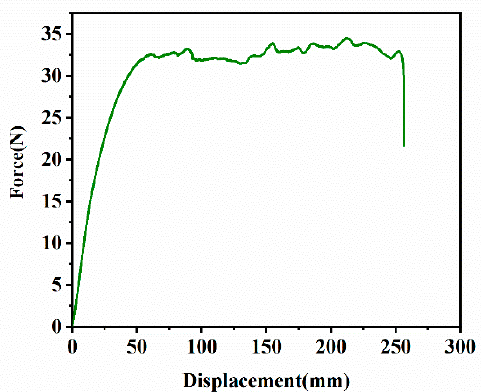
Figure 7. Force-displacement curve of the EPDM rubber composite under trouser tear.